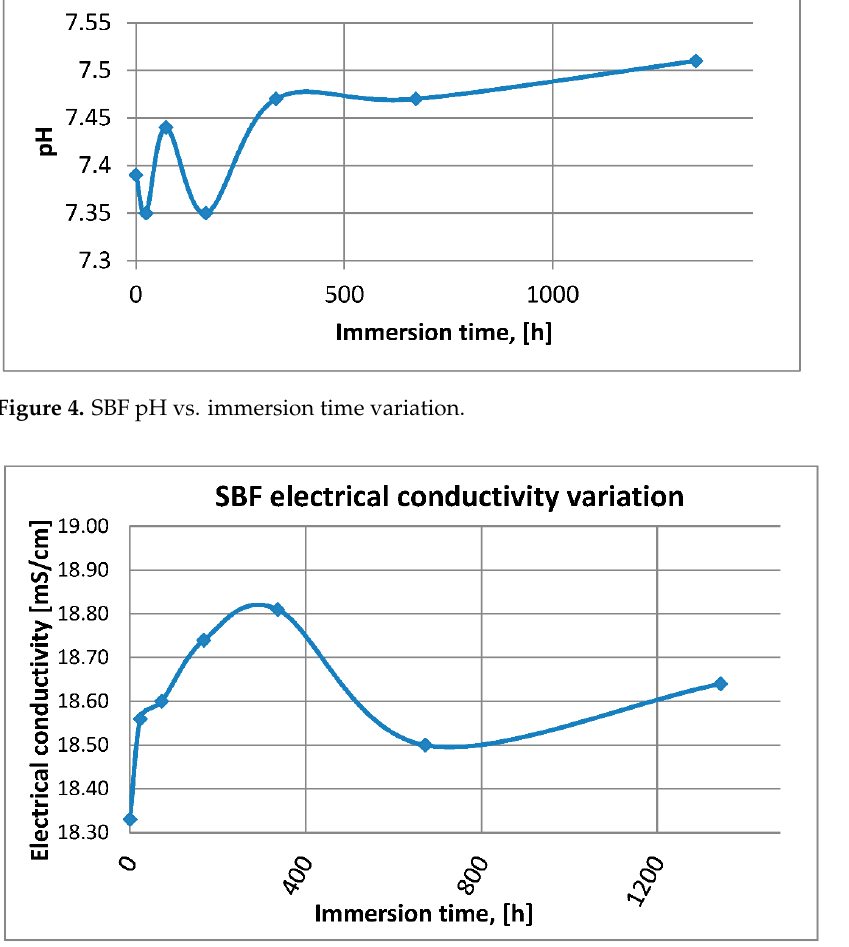
Figure 5. SBF electrical conductivity vs. immersion time variation. Table 3. Measured metal ion concentrations in the SBF.